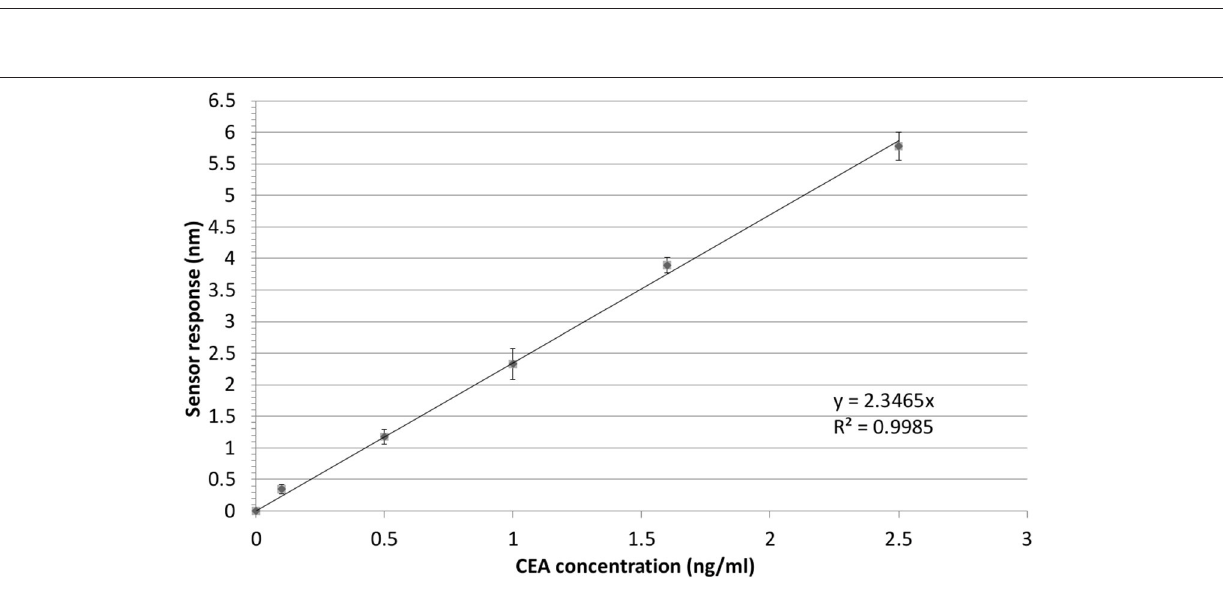
FIGURE 7 | Detection of CEA in PBS BSA employing sandwich assay with S-NPs: calibration curve. The SPR sensor response to the S-NPs (contact time with S-NPs solution: 10min) as a function of concertation of CEA. The error bars denote the standard deviation of the sensor response for each concentration. All the sensor response data are